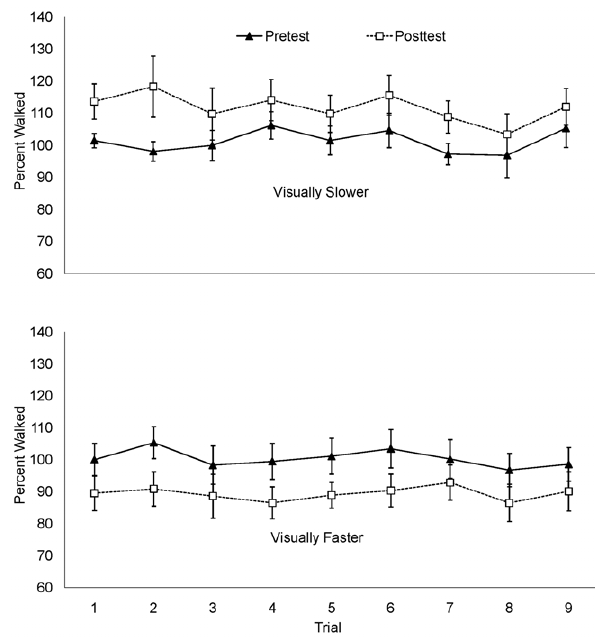
Figure 3. Percent walked by trial in Experiment 1.